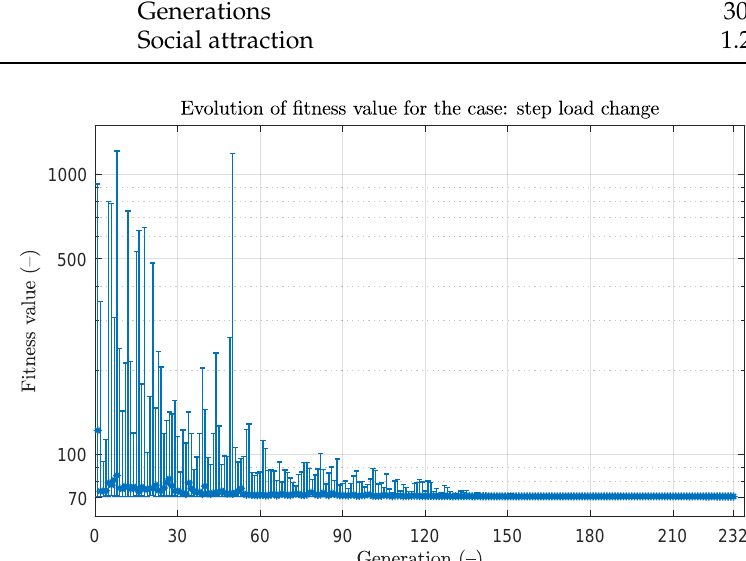
Figure 12. Evolution of fitness value for the case of step load change.